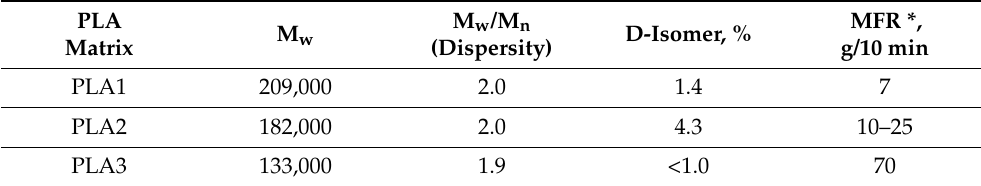
Table 1. Characteristics of PLAs used as the polymer matrix. PLA Matrix